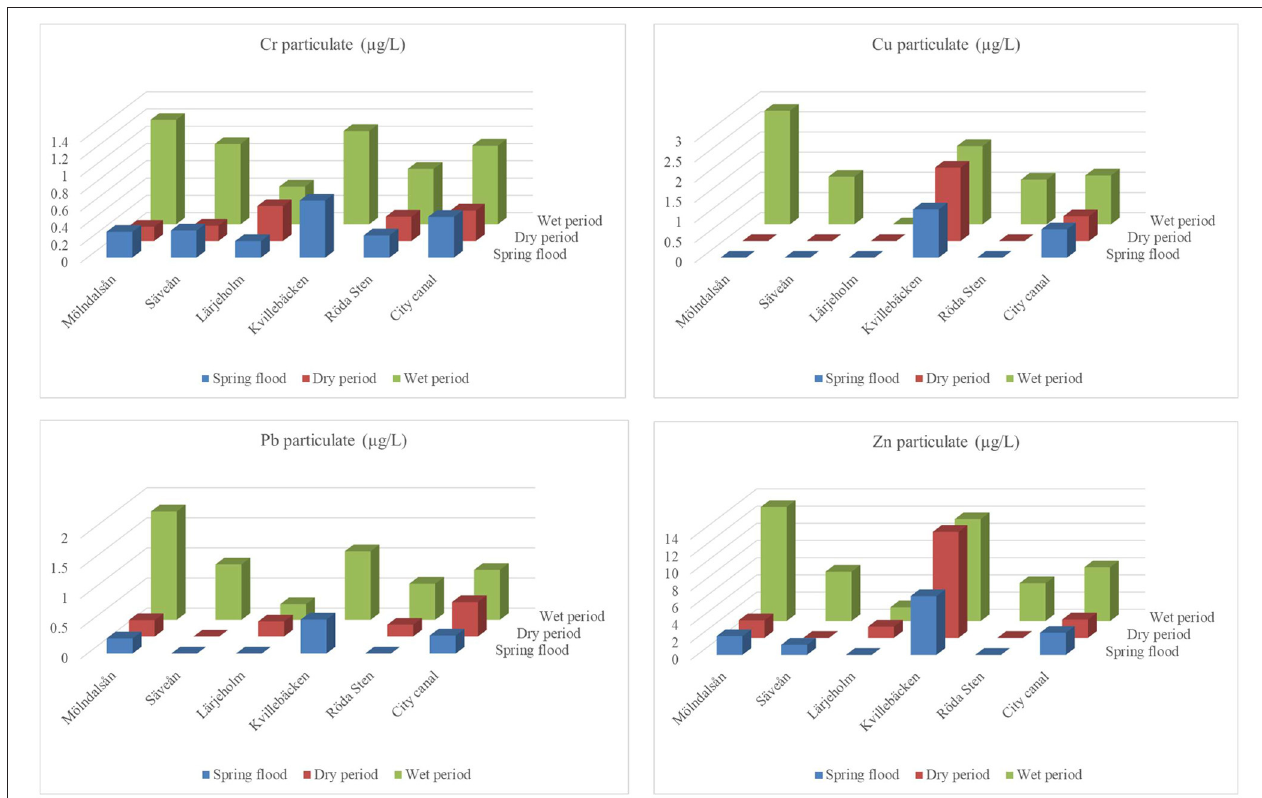
FIGURE 5 | Particulate concentrations of Cu, Zn, Cr, and Pb at sampling sites during the Spring flood, Dry period, and Wet period sampling